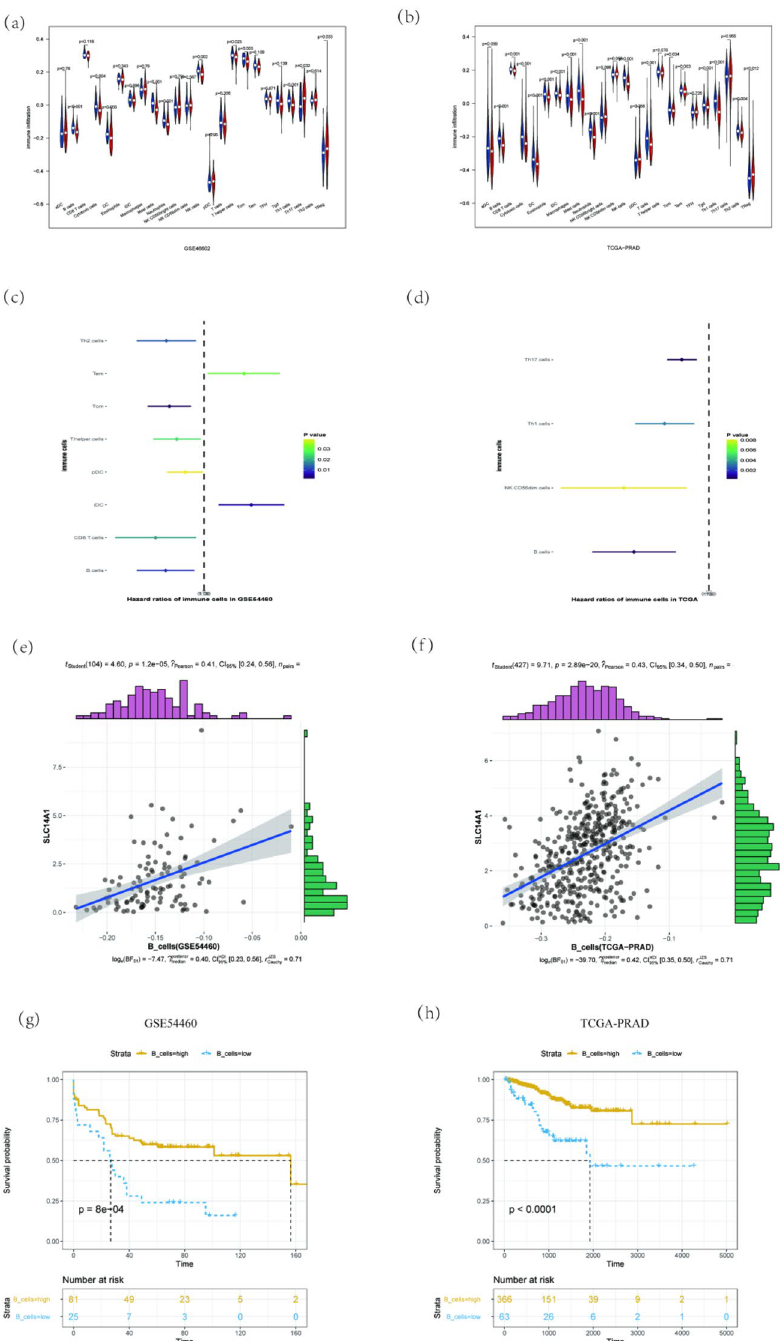
Figure 3. The associated analysis of SLC14A1 and immune cells. ( a ) and ( b ) used Wilcoxon test, ( c ) and ( d ) used univariate cox analysis. ( e ) and ( f ) show the correlation between SLC14Aa, data were obtained from GSE54460 and TCGA-PRAD, respectively. ( g ) and ( h ) show the Kaplan–Meier survival curves of B cells, data were also obtained from GSE54460 and TCGA-PRAD,